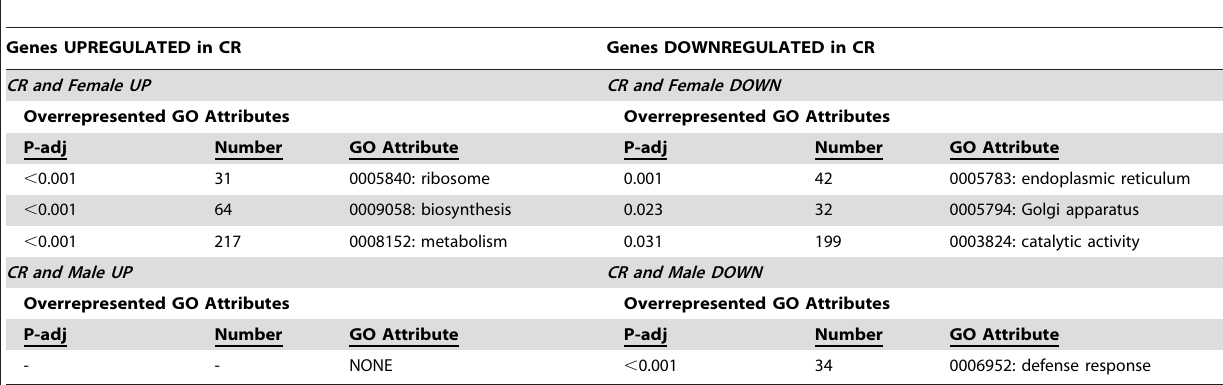
Table 2. GO categories associated with groups of genes displaying CR-regulated and sex-biased